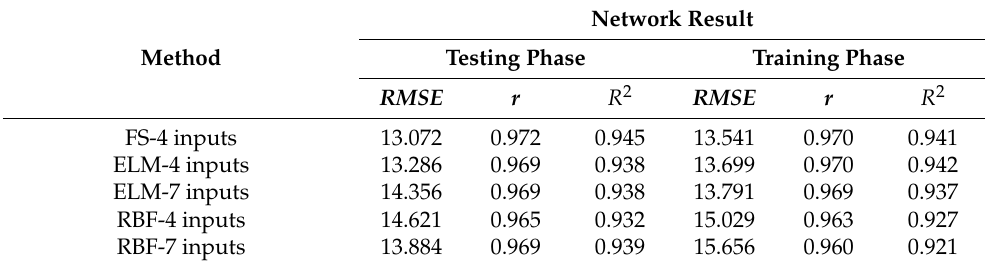
Figure 24. MPF regression charts: ( a ) four inputs, ( b ) five inputs, ( c ) six inputs, ( d ) seven inputs. Table 12. The calculated accuracy criteria for the performance of the implemented models for different neural